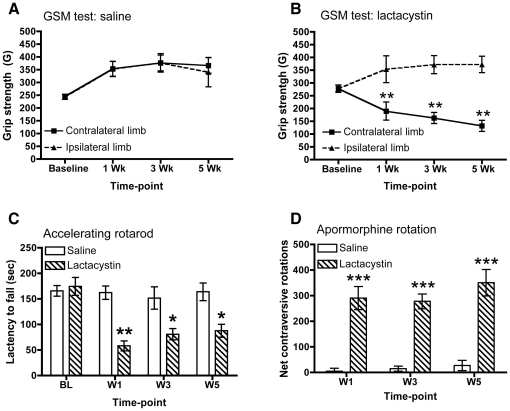
Parkinsonian-like motor phenotype in Lactacystin-lesioned animals.(A) Saline-injected controls show no deficits in the GSM test for either limb at any time-point. (B) Lesioned animals develop a progressive impairment in the grip strength of the contralateral forelimb in the GSM test. Data shown in (A, B) are mean grip force (G) ± SEM. **p<0.01 contralateral limb vs. ipsilateral limb. (C) Lesioned animals, but not saline controls show motor co-ordination deficits as evidenced by shortened latency to fall in the accelerating rotarod test at all time-points post-surgery. Data shown are mean latency to fall (sec) ± SEM. *p<0.05; **p<0.01; saline vs. lactacystin-injected. (D) Lactacystin-lesioning induces significant contralateral circling in response to apomorphine challenge (0.1 mg/kg s.c.) at all time-points post-surgery. Data shown are mean net contraversive rotations ± SEM. ***p<0.001; saline (N = 5) vs. lactacystin-injected (N = 7).